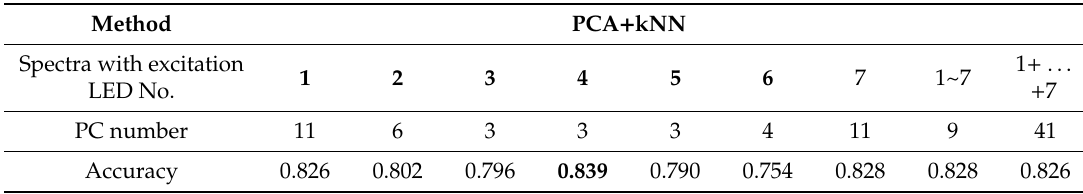
Table 1. The accuracy of the test set samples with models trained by PCA combined with kNN with different training data set. The best performance is highlighted.